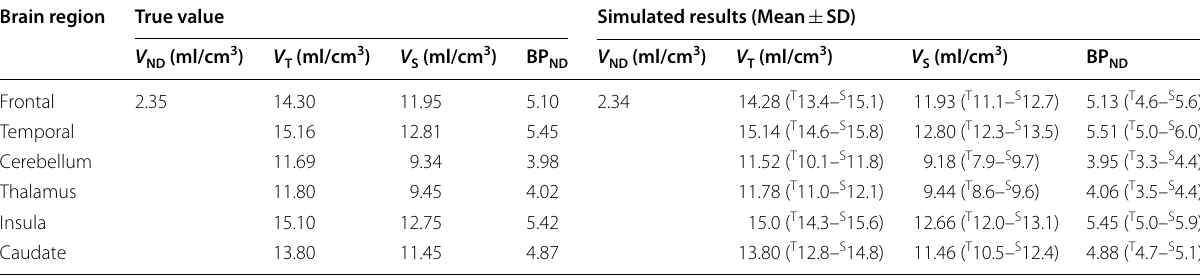
T 25th percentile and S 75th percentile